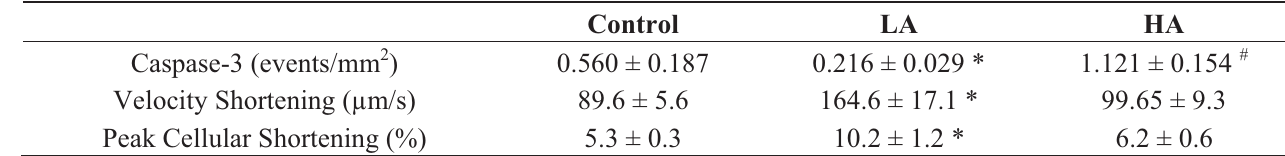
Table 1. Chronic low alcohol subjects displayed significantly less caspase-3 events accompanied by an increased velocity shortening and peak cellular shortening compared to